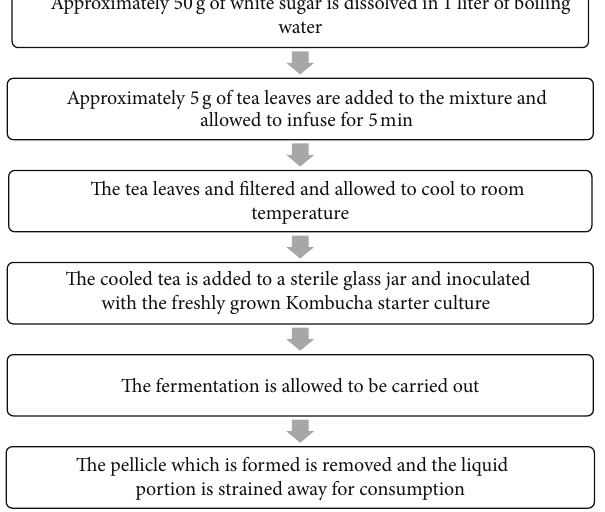
Figure 1: The typical method of preparation of the Kombucha beverages using sugared black